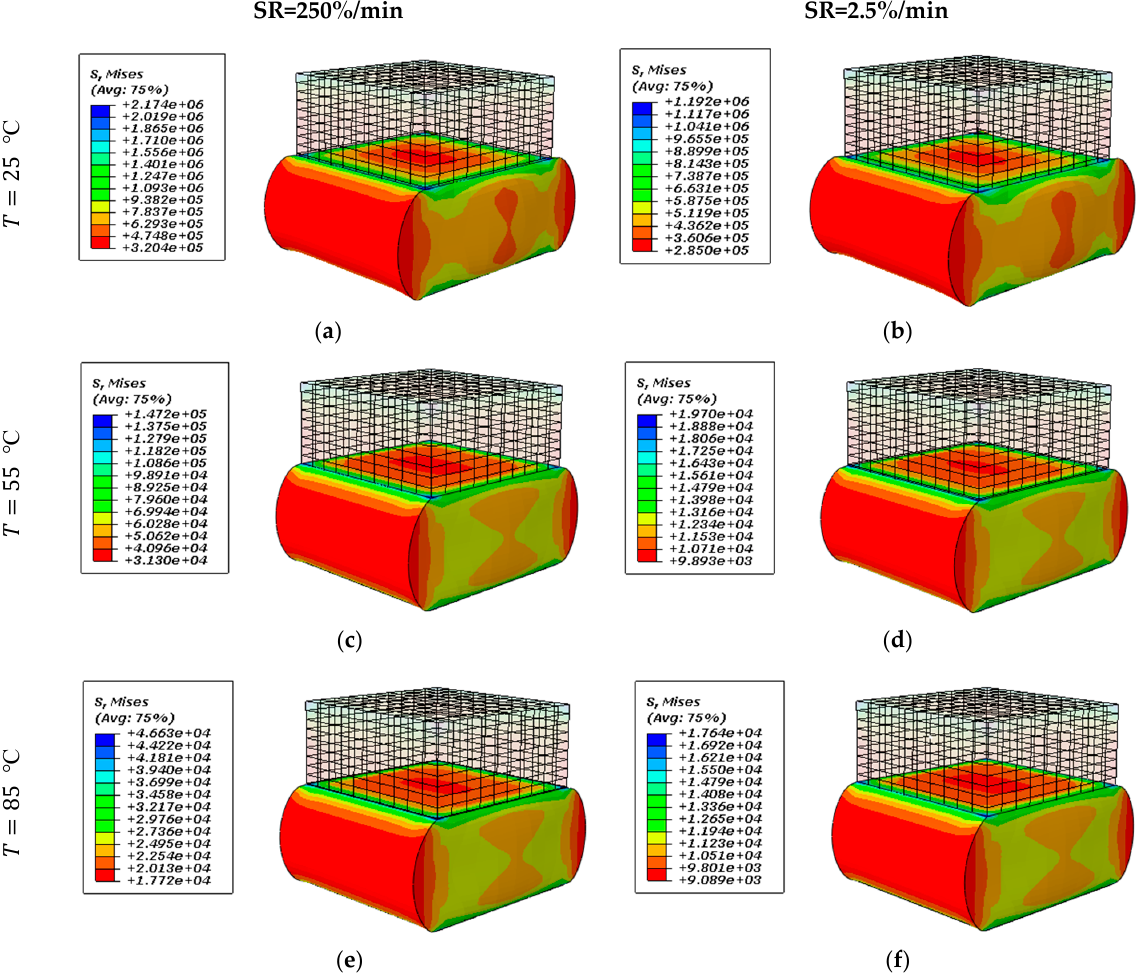
Figure 13. Stress distribution of PU SMP foams at different temperatures and strain rates at the end of loading for ( a ) T=25 ℃ , SR=250%/min, ( b ) T=25 ℃ , SR=2.5%/min, ( c ) T=55 ℃ , SR=250%/min, ( d ) T=55 ℃ , SR=2.5%/min, ( e ) T=85 ℃ , SR=250%/min, and ( f ) T=85 ℃ , SR=2.5%/min.